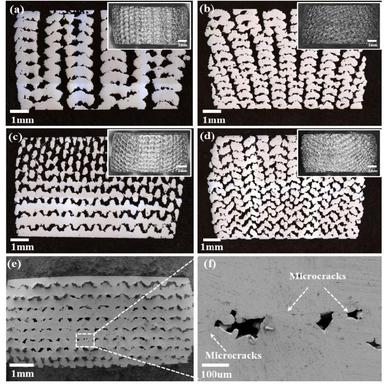
(a–d) OM images of four TPMS pore-gradient structures after compression; (a) relative density grading of gyroid, (b) cell size grading of gyroid, (c) relative density grading of diamond, (d) cell size grading of diamond and (e and f) SEM images of the relative density grading of diamond structure after compression.